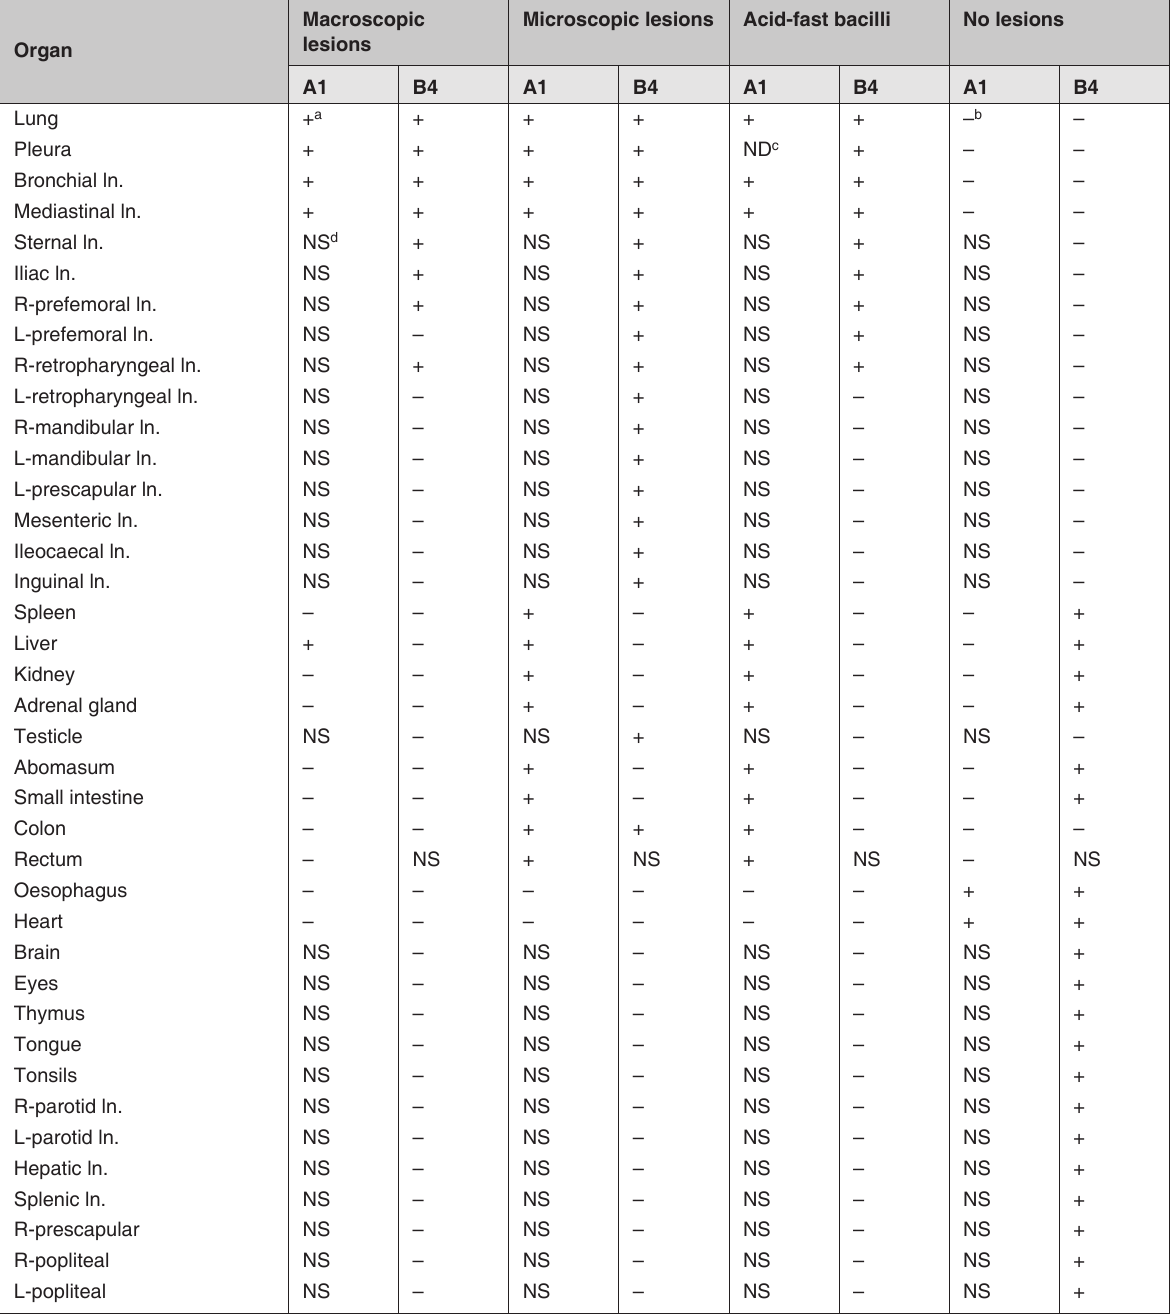
Microscopic lesions Acid-fast bacilli